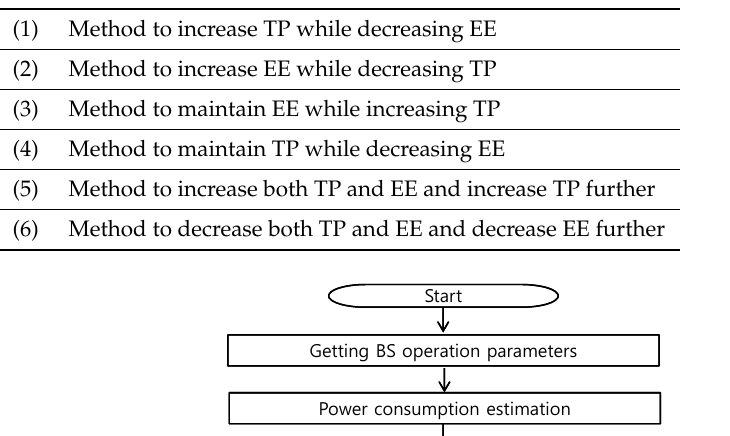
Table 4. Examples of BS operation. TP: throughput; EE: energy efficiency.